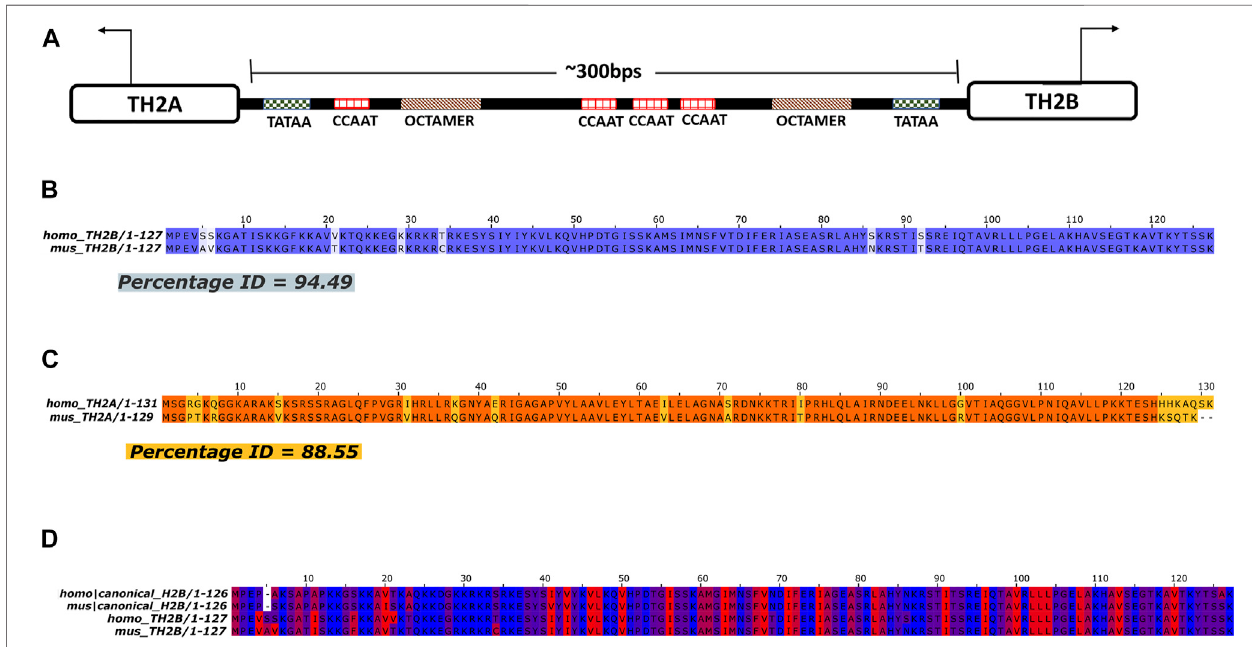
FIGURE 1 | Pairwise Alignment of TH2B and TH2A in Human and Mouse. (A) Structure of the TH2A and TH2B gene showing bi-directional promoter (direction of transcription indicated by arrows) with protein binding sites. (B, C) Pairwise alignment of protein sequences maps to depict homology between homo (human) and mus (mouse)TH2B and TH2A, respectively. (D) Clustal omega Multiple Sequence Alignment (MSA)map forhomo and mus H2Band TH2B depicting hydrophobicityofeach residue in the protein sequence. Red being hydrophobic and blue being hydrophilic residues.